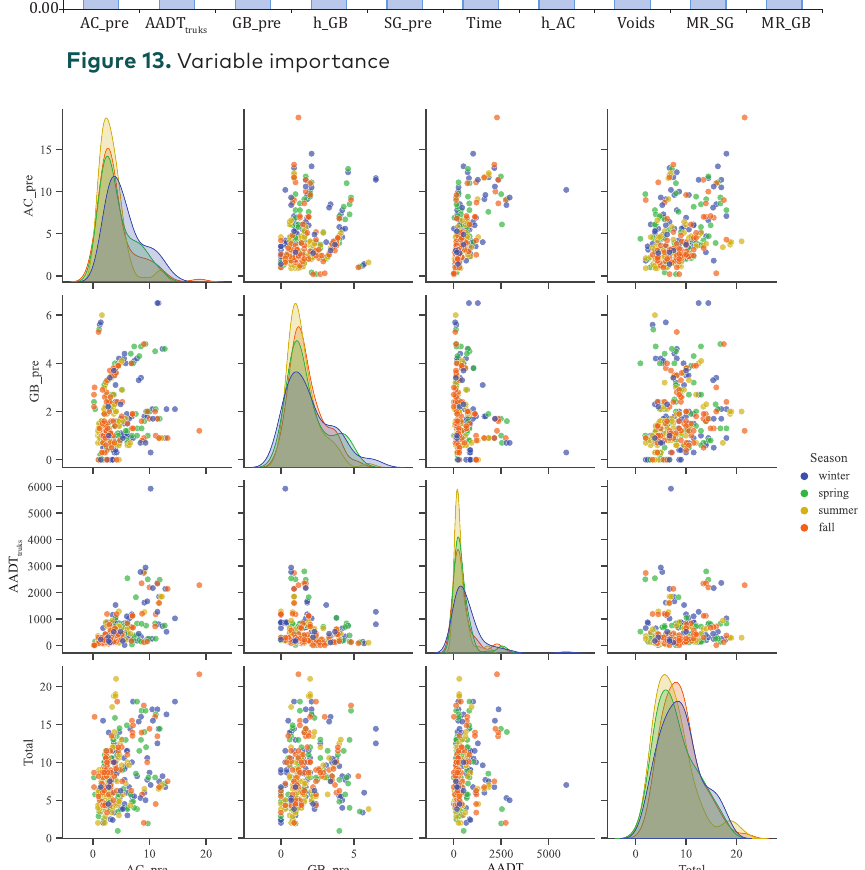
Figure 14. A plot matrix for the variables considered